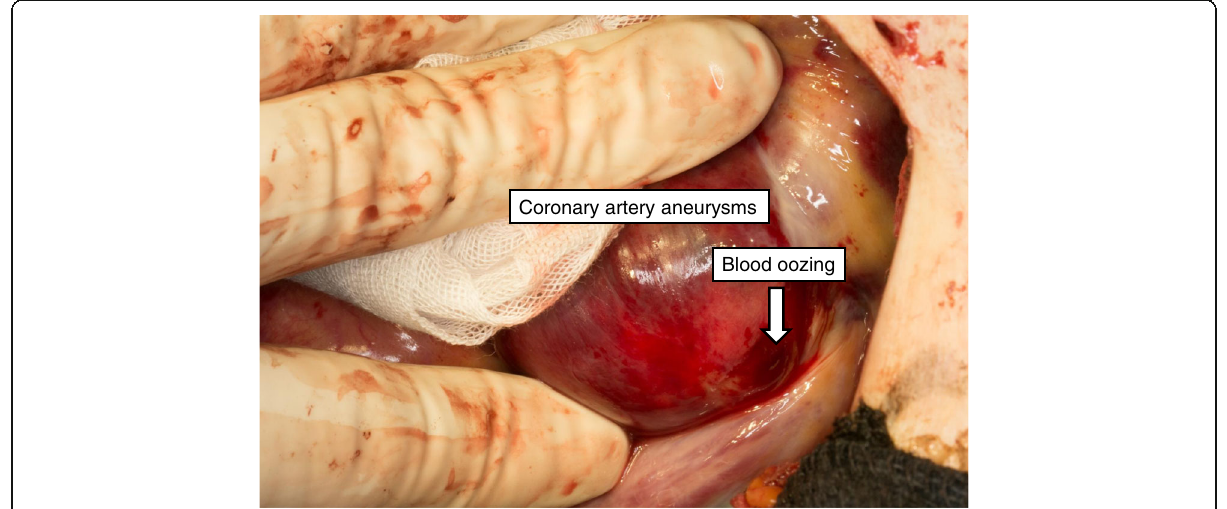
Fig. 4 Intraoperative photograph. Blood oozing (arrow) on the wall of the giant coronary artery